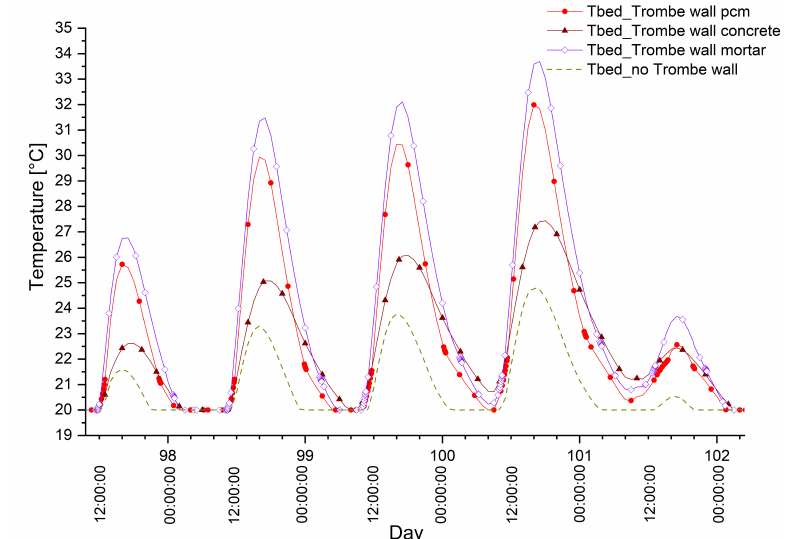
Figure 16. Comparison of temperature variations inside the bedroom both with and without application of the solar Trombe